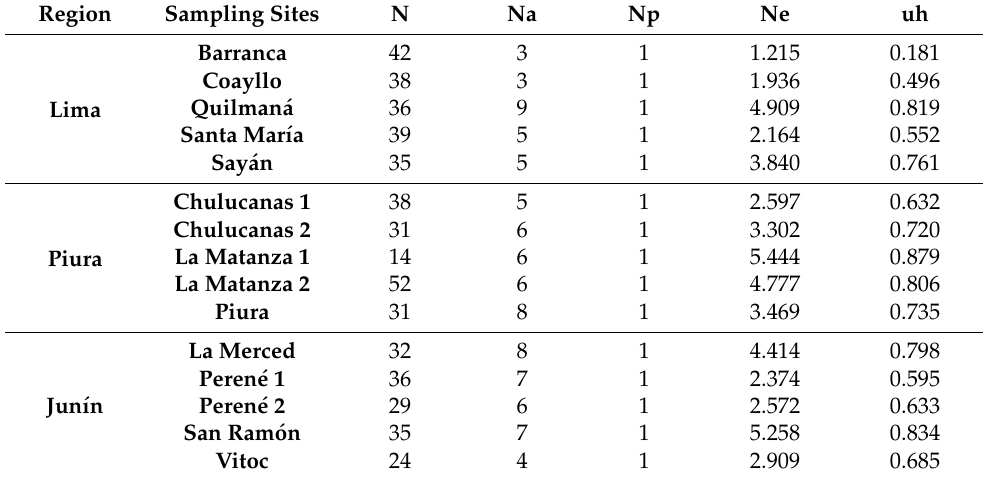
Table 1. Diversity measures for each of the sampling sites the three Peruvian regions.